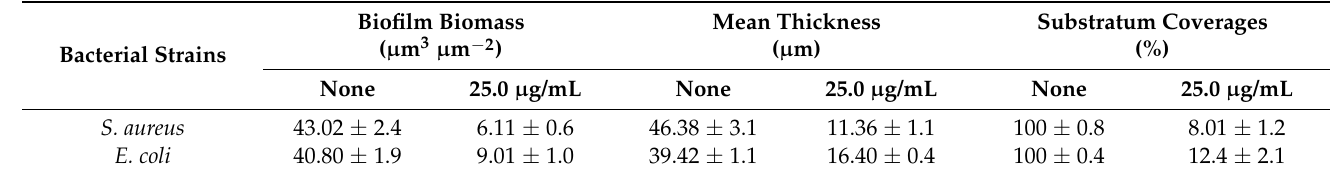
Figure 11. Effects of bio-reduced CuO NPs on S. aureus ( A ) and E. coli ( B ) biofilm formation. ** p < 0.01 * p < 0.05 Vs. non-treated controls. Scale bars represent 100.0 µm. Table 3. COMSTAT analysis of biofilm biomass, mean thickness, and substratum coverage spatial characteristics.